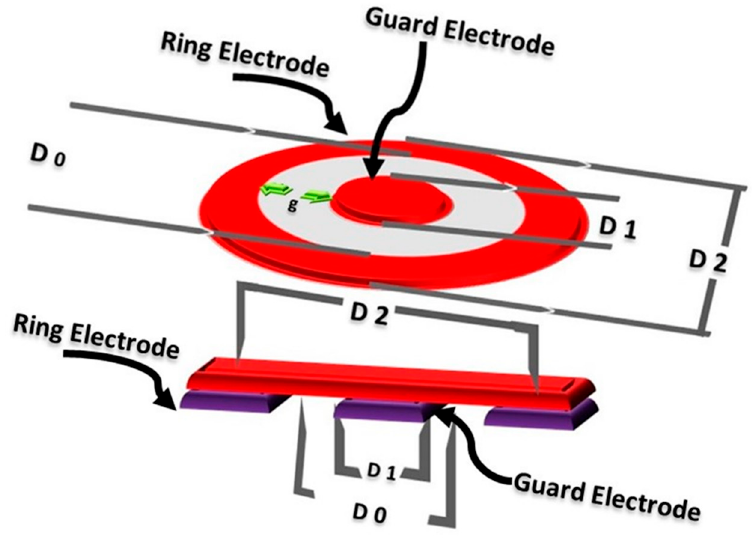
Figure 3. Scheme of concentric electrodes for the measurement of electrical resistance